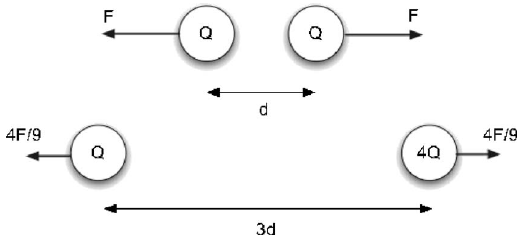
FIG. 12. Figure for the two-charge problem (cid:1) with the answer shown (cid:2)